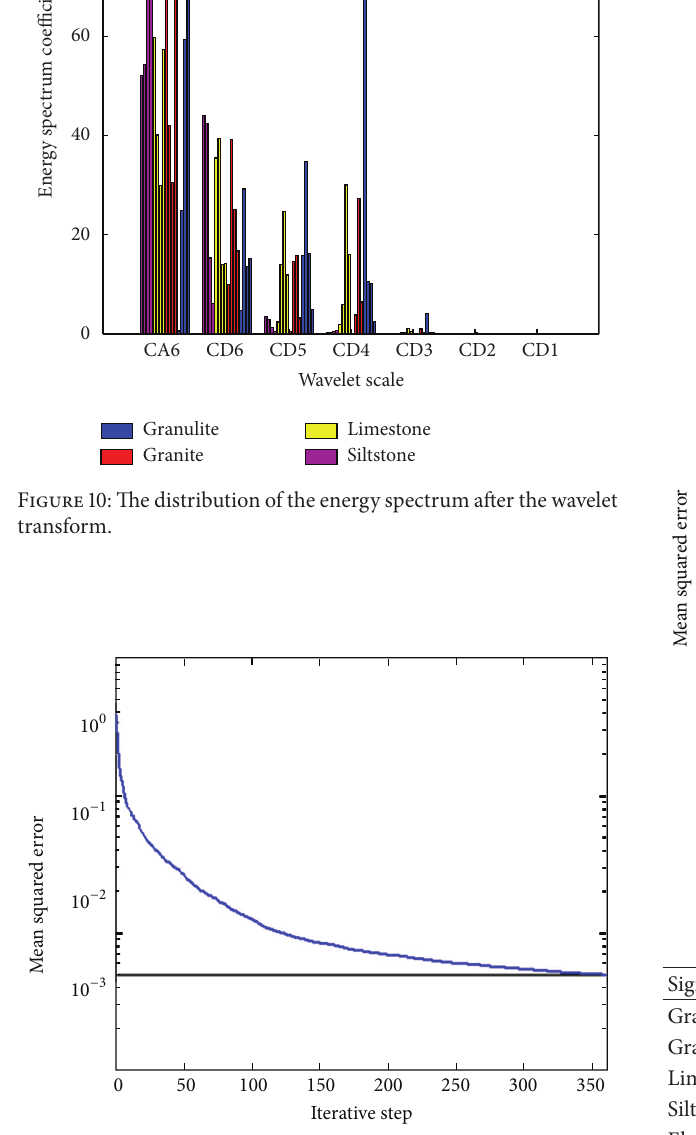
Figure 11: Convergence curve using the logsig function.